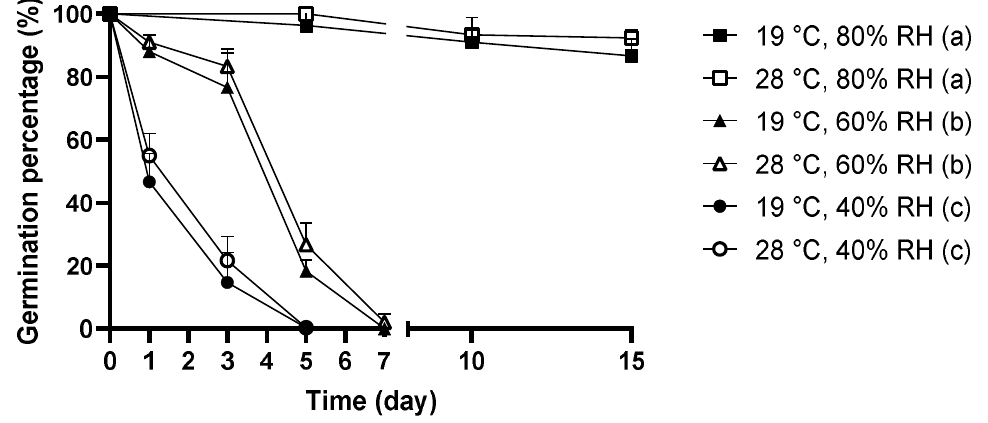
Figure 1. The germination percentage of C. cladosporioides spores exposed to moisture dynamics with different combinations of RH and temperature levels. The changes in germination percentage under moisture dynamics were analyzed by repeated measures one-way ANOVA. Grouping was performed by Duncan’s post-hoc test. Letters in parentheses indicate different groupings.